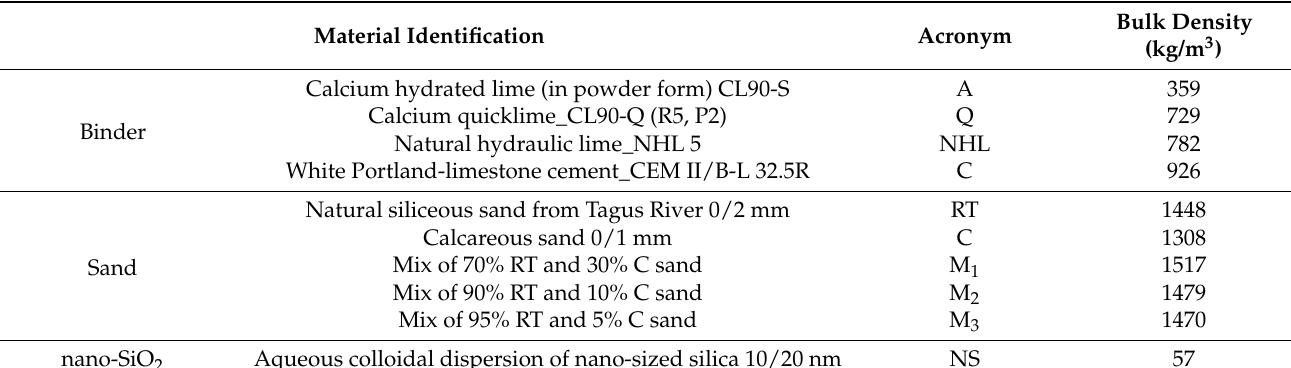
Table 1. Identification and properties of the raw materials.